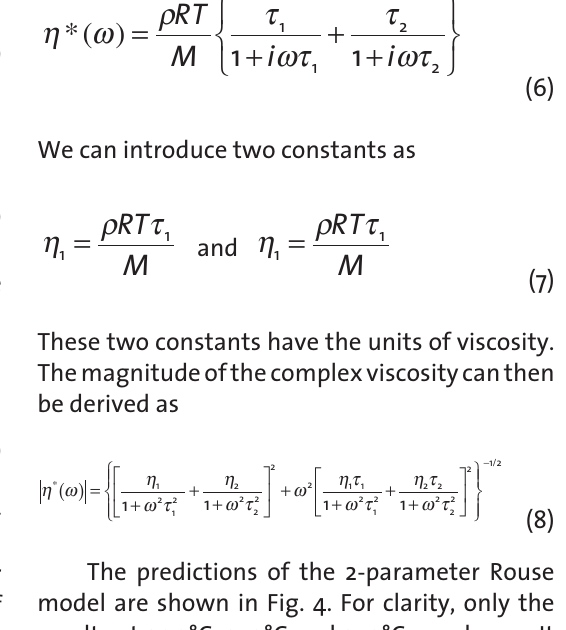
Fig. 2 (left): 1-parameter Rouse fit (lines) to the com- plex viscosity (symbols) as a function of frequency for the Pglass at the temperatures indicated. Fig. 3 (middle): HPLC data of the Pglass. Fig. 4 (right): 2-parameter Rouse fit (lines) to the com- plex viscosity (symbols) as a function of frequency for the Pglass at the temperatures